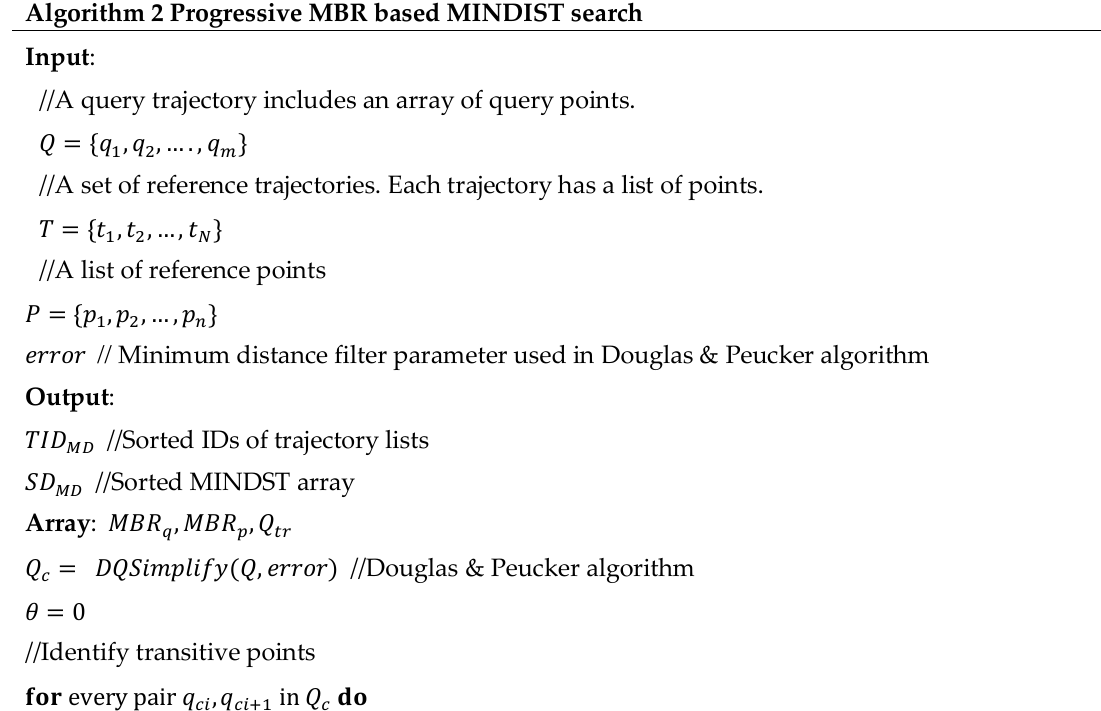
Algorithm 2 Progressive MBR based MINDIST